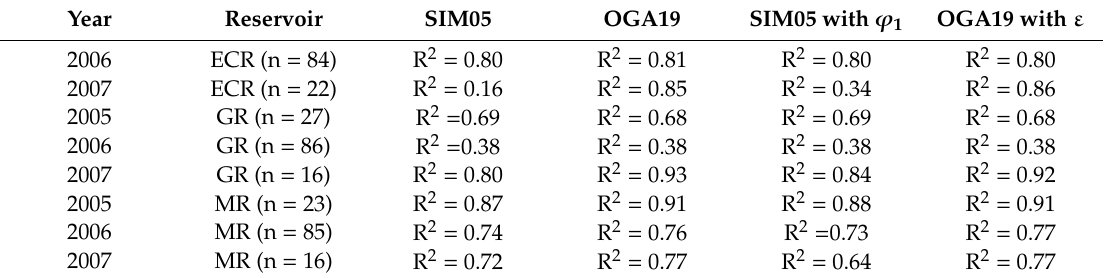
Table 11. Comparison of SIM05 and OGA19 for their sensitivity to ϕ 1 and ε . Bold font indicates the best model performance for each